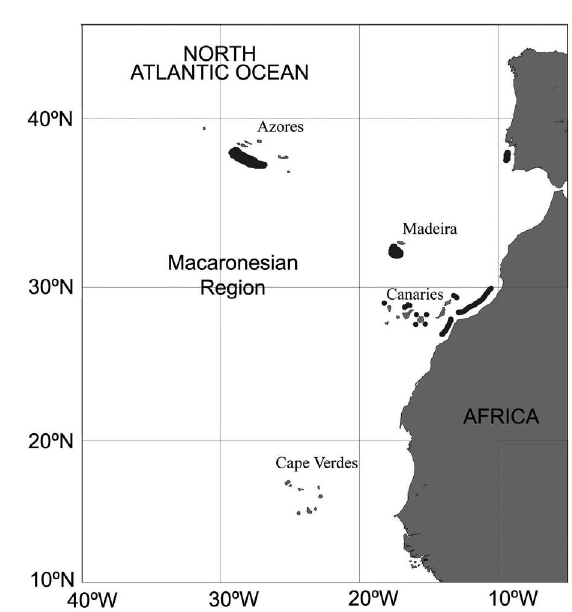
Fig. 1. – Map of the study area in the NE Atlantic Ocean showing the locations where specimens of A. carbo and A. intermedius were